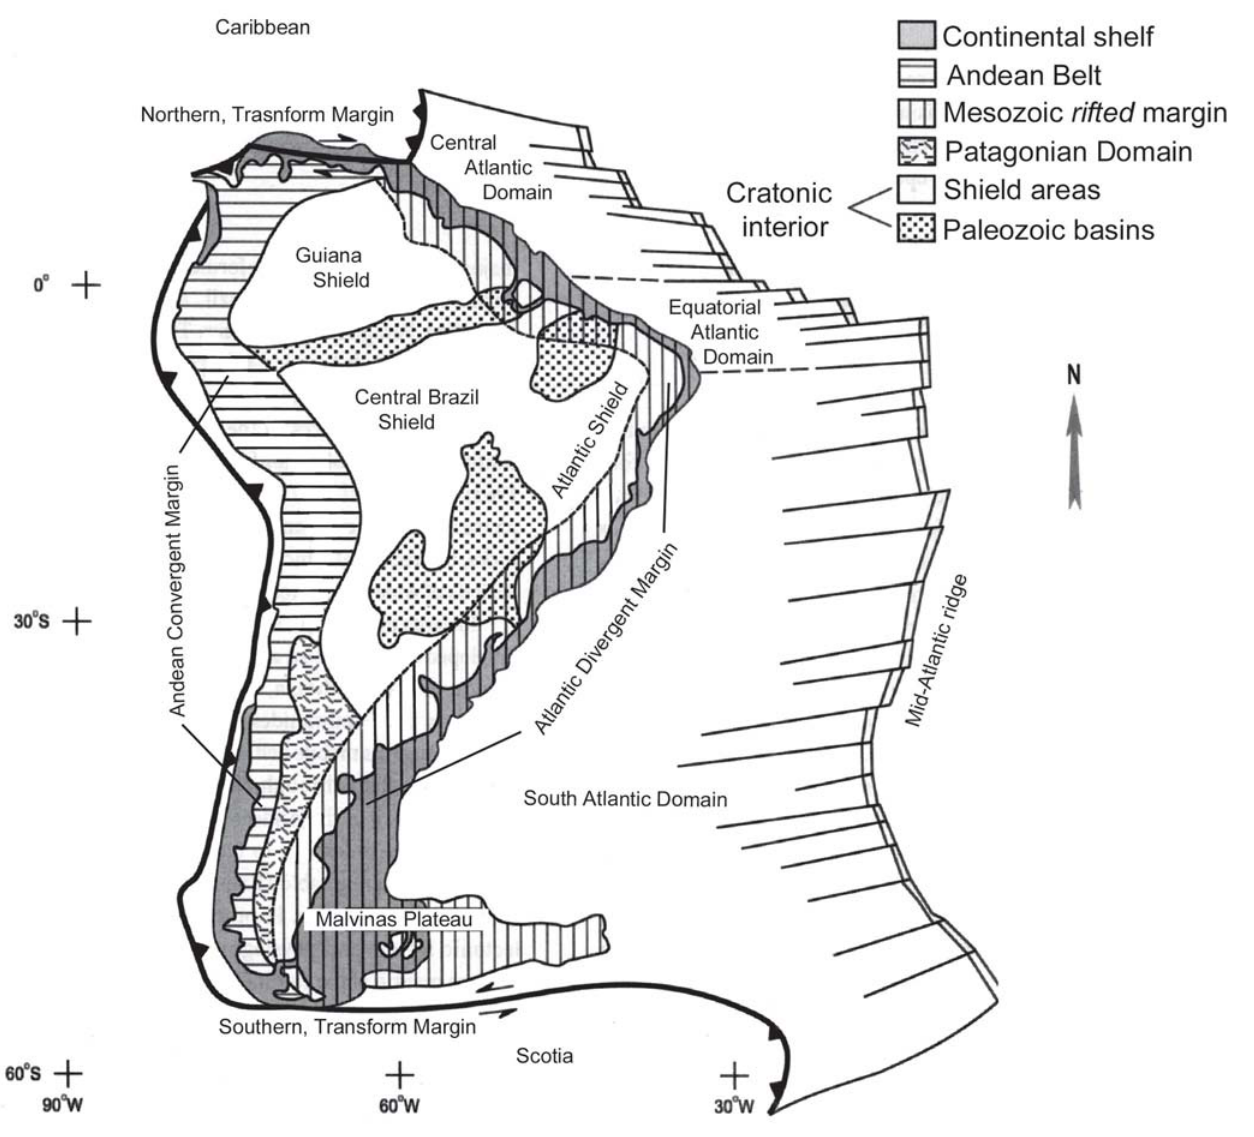
Fig. 2 . The South American Plate and its major tectono-sedimentary domains (from Milani & Thomaz-Filho,